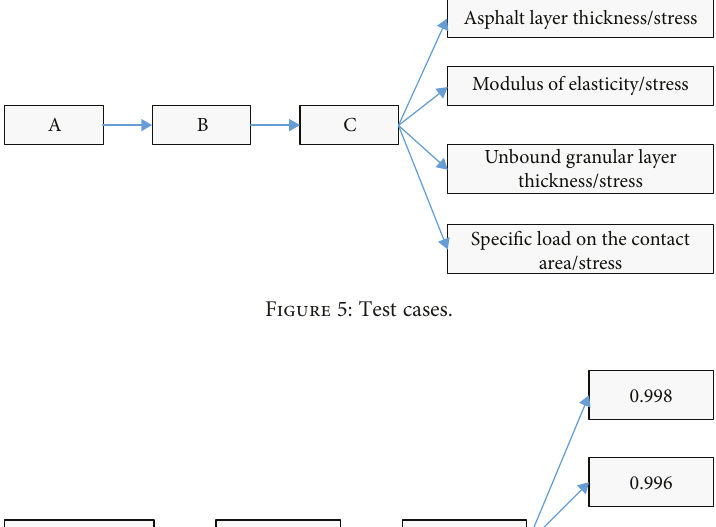
Figure 6: Test results.